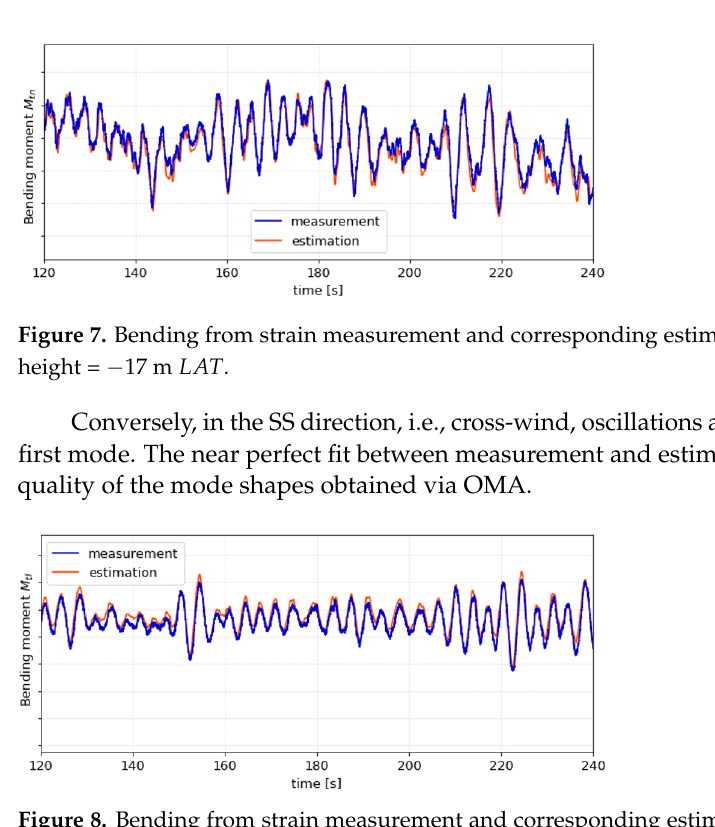
Figure 8. Bending from strain measurement and corresponding estimation in the SS direction for height = − 17 m LAT .